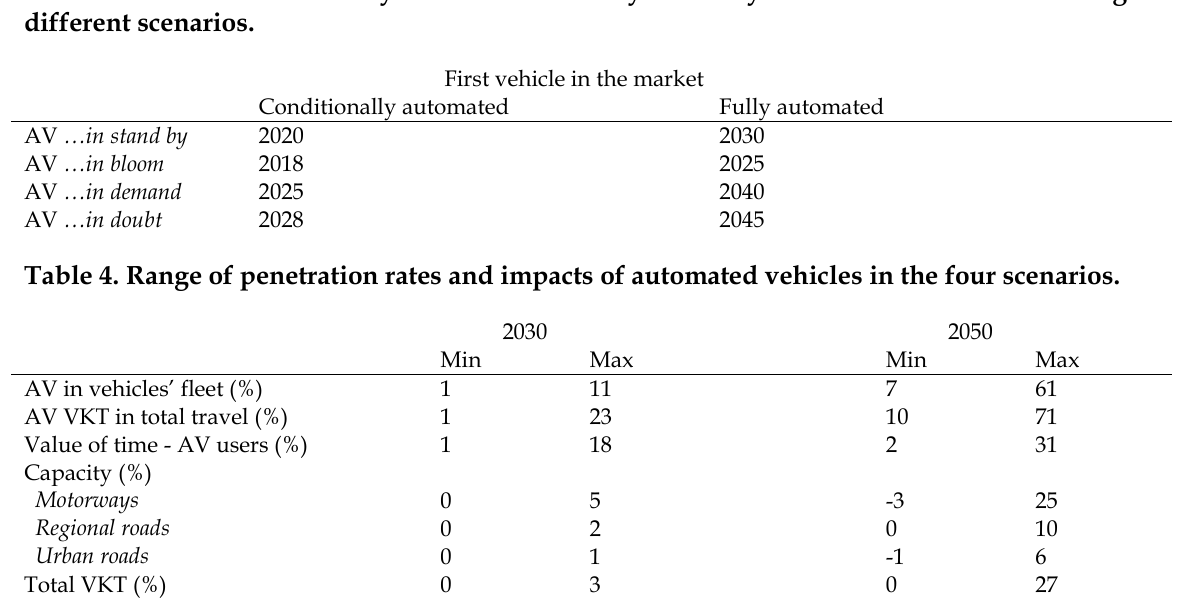
Table 3. Market introduction year for conditionally and fully automated vehicles according to different scenarios.